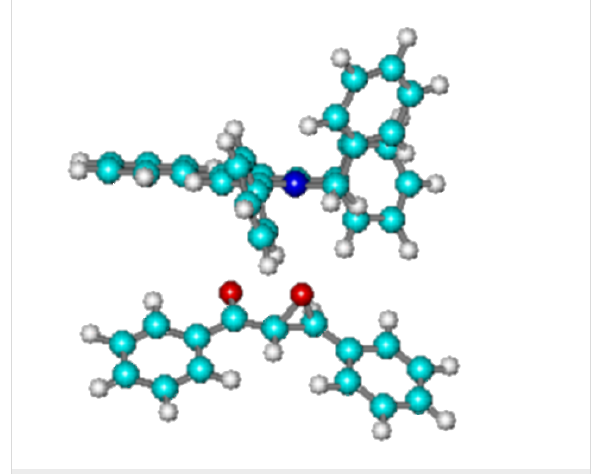
Figure 1: The semi-empirical PM3 calculations for interaction of 1a with